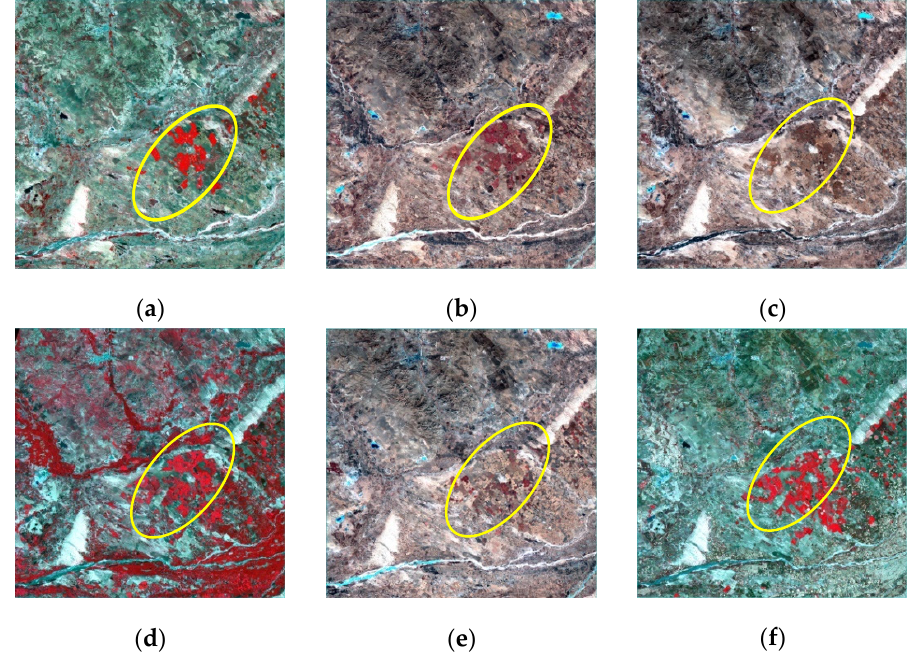
Figure 8. Landsat images from the AHB dataset reflecting changes in phenology in rural and mountainous areas. Dates: ( a ) 30 May 2013; ( b ) 10 February 2014; ( c ) 17 March 2015; ( d ) 26 August 2016; ( e ) 18 February 2017; ( f ) 3 October